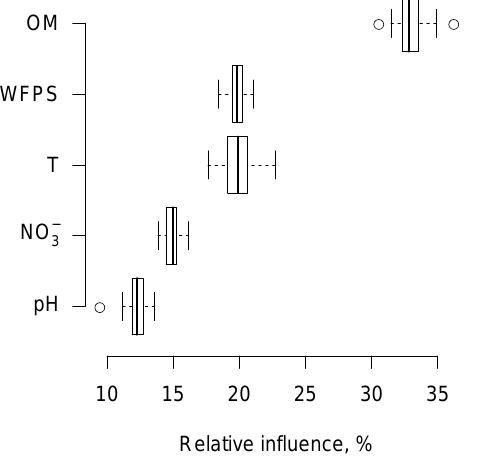
Fig. 3. Boxplot (description of quartiles with maximum at 1.5 interquartile range) of relative influences of the 5 input variables, as revealed by the BRT5(OM,pH)G model. Circles are outlier candidates.